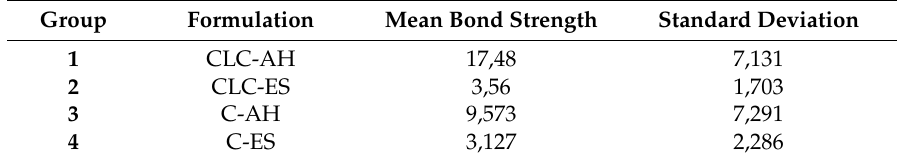
Table 1. Mean push-out bond strengths (MPa) and standard deviations for the experimental groups.